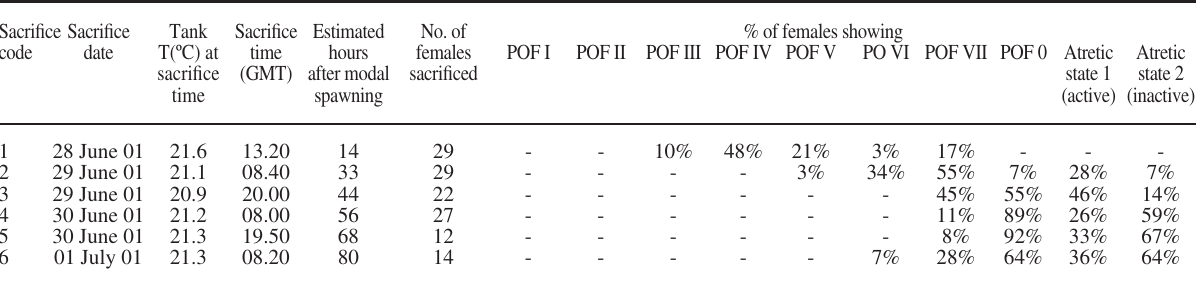
Table 4. – results of the gonad analysis of the females from Aquarium experiment F, presented by sacrifices, date and time (gMt) of each sacrifice and elapsed time after assumed modal spawning time. sacrifice sacrifice tank sacrifice estimated no. of % of females showing code